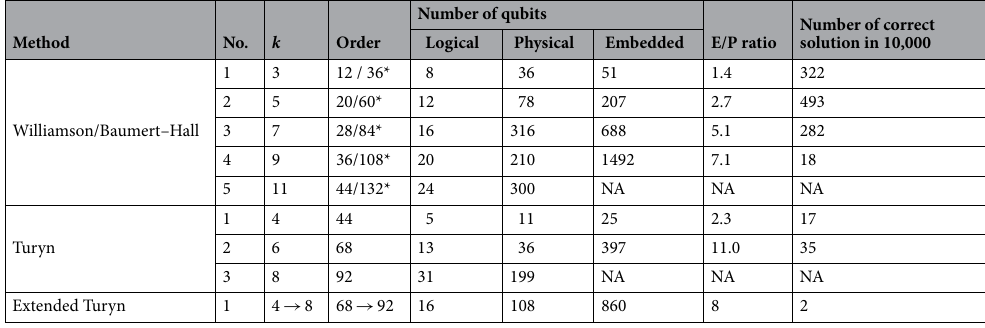
Table 1. Resource required in the proposed quantum computing methods. The Willamson and Baumert– Hall based method: to find an M order H-matrix, the required logical qubits grows by O ( M ) and the physical qubits by O ( M 2 ) . Embedding the connections implied by the Hamiltonian on existing Chimera graph further increases the required qubits, which ultimately limit the capability of the method. Decreasing percentage of correct solutions, knowing that only 10,000 reads in a single run is allowed, indicates that repeated experiments will be needed to find higher order matrices. The Turyn-based quantum computing method: although the number of required physical qubits also grows by O ( M 2 ) , the jump among the order is high so that the next one after order 68, i.e. 92 and beyond,cannot successfully be embedded in DW-2000Q . We also cannot conclude the success rate for given 10,000 number of reads due to lack of data, although we may suspect that it will also decrease as in the Williamsons and Baumert–Hall adopted methods. Extended Turyn based method: the number of logical qubits is determined by the number of additional k in the extension (cid:31) k , not by the final qubits. We show the result of extending order k = 4 into k = 8 and only one of successful solution prototypes in the table. *Order for Williamson / Baumert–Hall method.